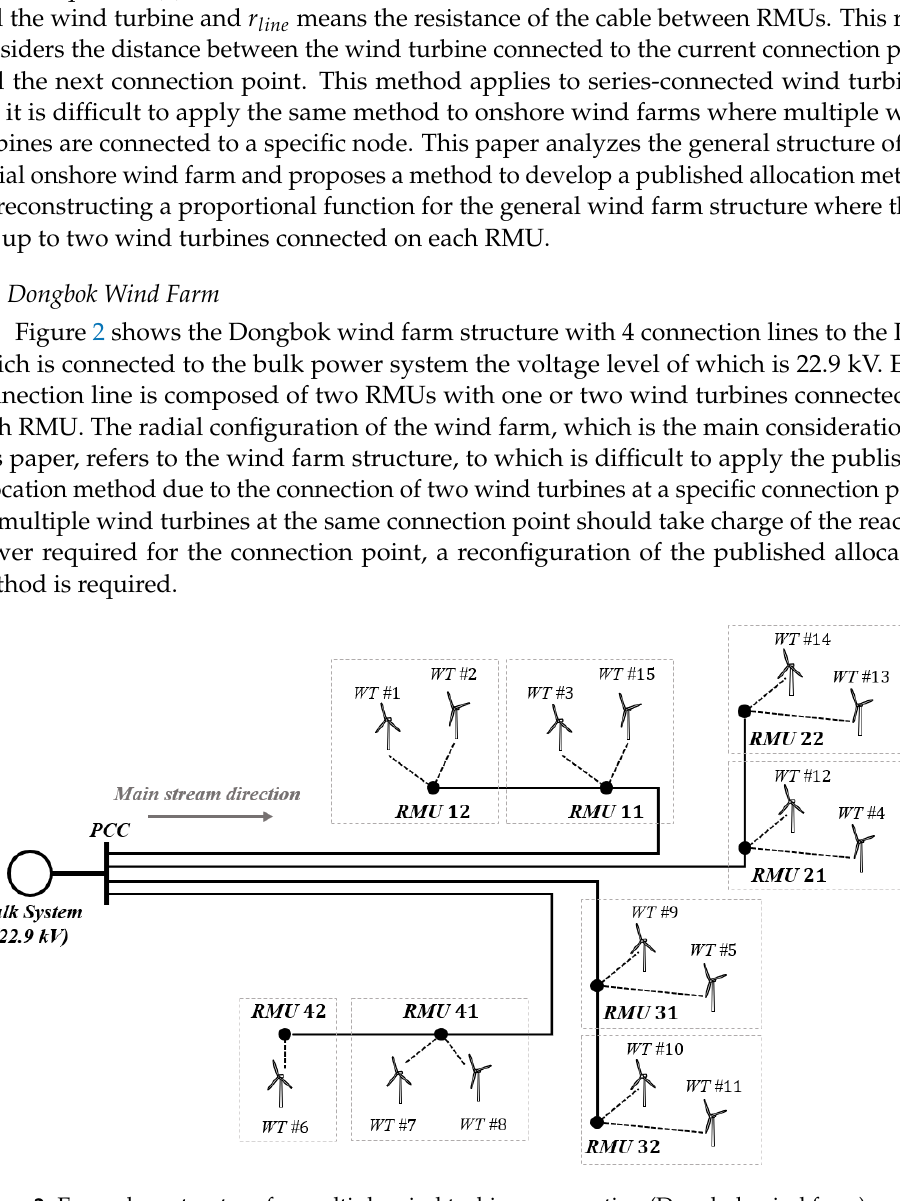
Figure 2. Exemplary structure for multiple wind turbines connection (Dongbok wind farm).